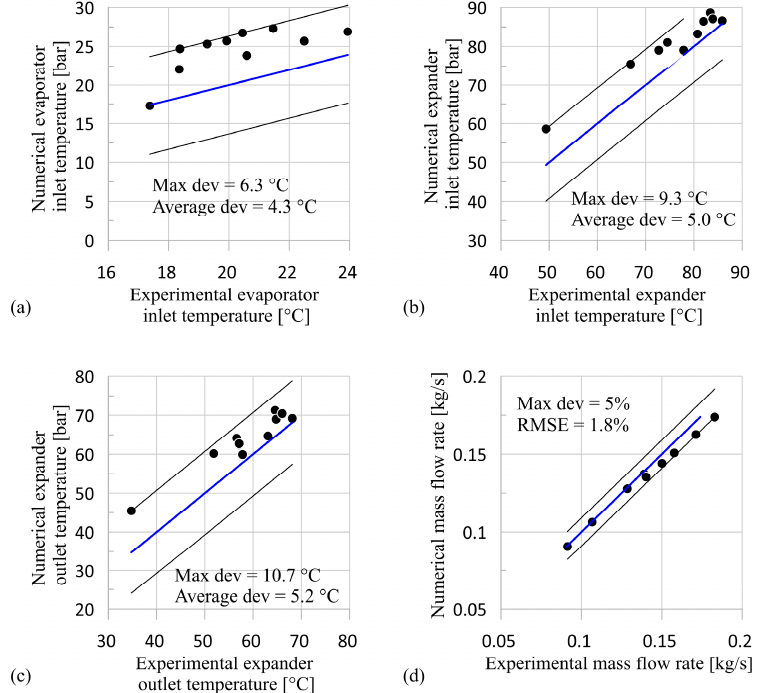
Figure 8. Comparison between the experimental and predicted ( a ) temperature at evaporator inlet; ( b ) temperature at expander inlet; ( c) temperature at expander outlet; and ( d ) WF mass flow